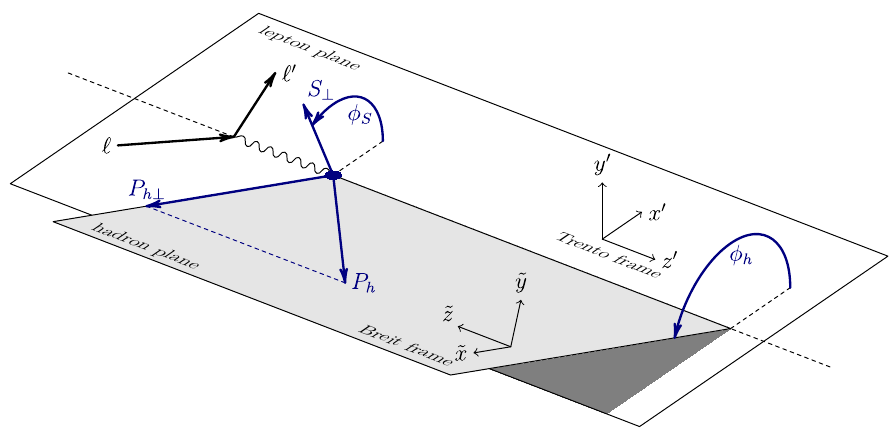
Figure 1 . Illustration of the SIDIS kinematics in the target rest frame according to the Trento convention [100], specified by the unit vectors x 0 , y 0 , z 0 . The momentum transfer ~q is aligned along the z axis, and the hadron transverse momentum ~P is defined relative to the lepton plane. We hT also show the hadronic Breit frame ˜ B employed in our tensor decomposition, specified by the unit vectors ˜ x, ˜ y, ˜ z . Its ˜ z -axis is opposite to that of the Trento conventions, and the ˜ x − ˜ z plane coincides with the hadron plane rather than the lepton